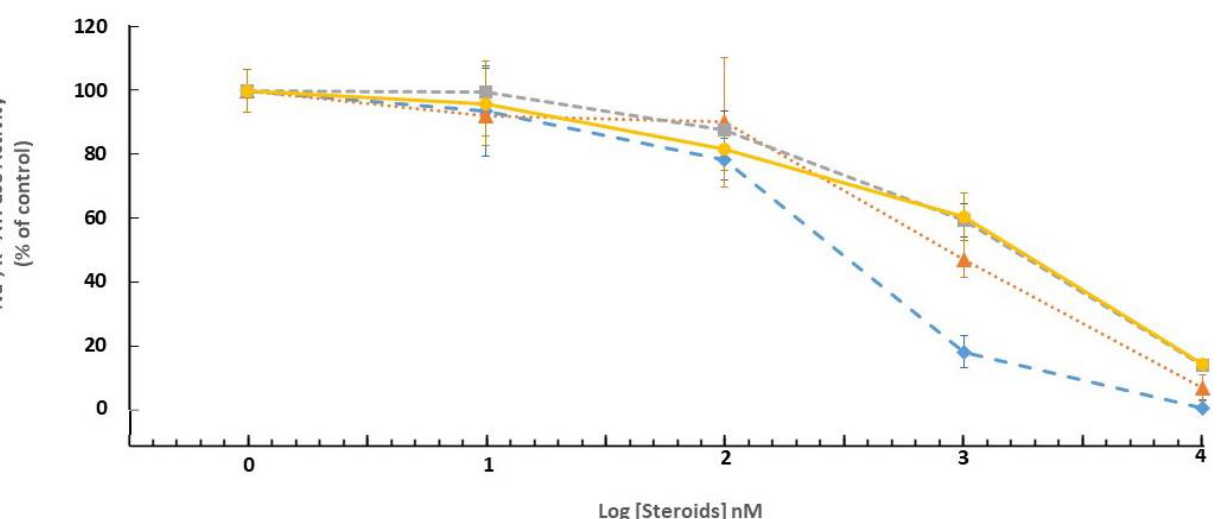
Figure 6. Effect of CS on brain microsomal Na + , K + -ATPase activity. A pig brain microsomal fraction was exposed to different concentrations of the steroids; reactions (37 ◦ C, 30 min) were terminated by the addition of TCA. The inorganic phosphate content of the samples was determined as described in Materials and Methods. The results are expressed as % Na + , K + -ATPase activity (4.72 µ mol Pi/ µ g protein/h.), representing 81% of the total ATPase activity (5.78 µ mol Pi/ µ g protein/hr.) in the absence of steroids. The effects of bufalin (blue, (cid:7) ), Bufalin 2,3-ene (orange, (cid:78) ), bufalin 3,4-ene (grey, (cid:4) ), and ouabain (yellow, • ) are shown. Values are expressed as the mean ± SE (error bars) of 3 experiments.